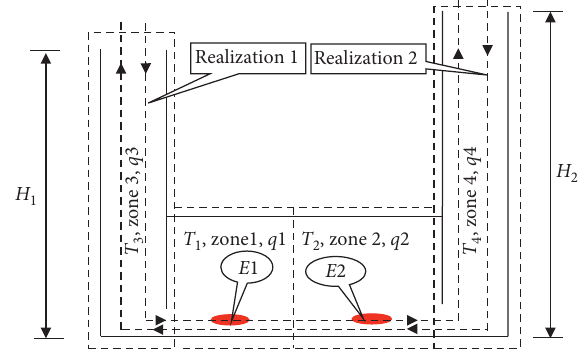
Figure 1: Proposed schematics of four-zone underground